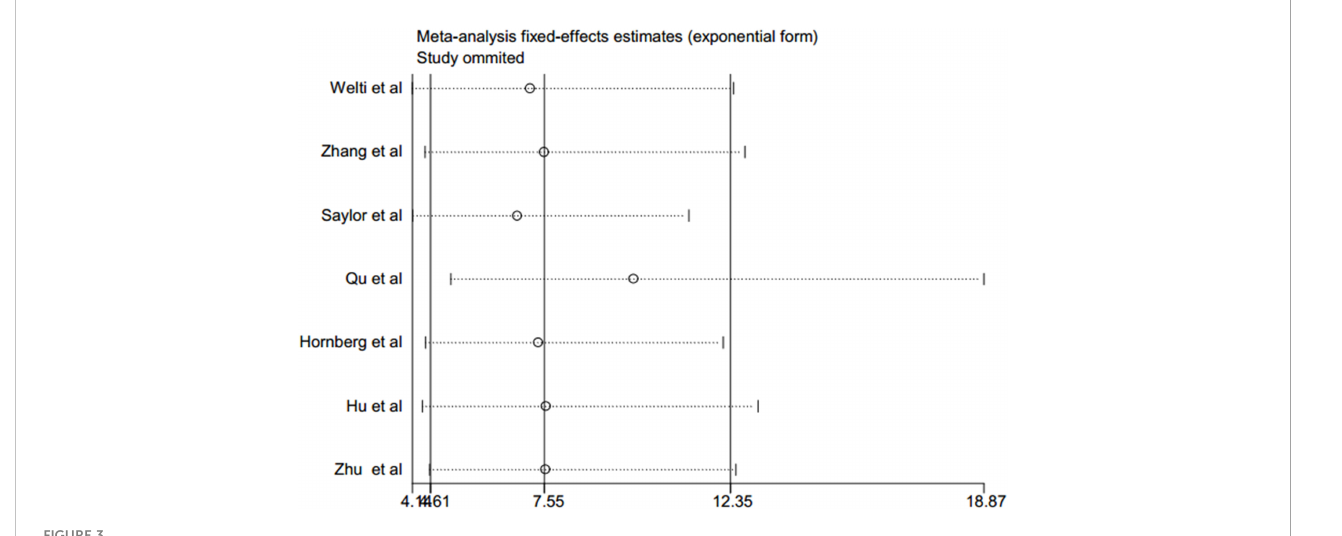
TABLE 3 Subgroup analysis of the association between CRPC and positive expression of AR-V7.